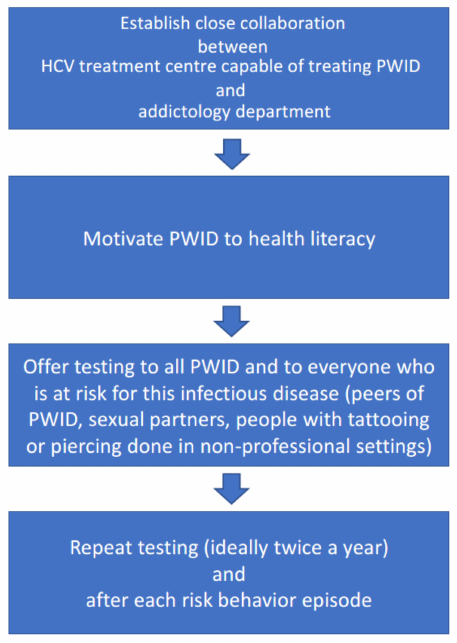
Figure 5. Viral hepatitis C diagnosis—simplified